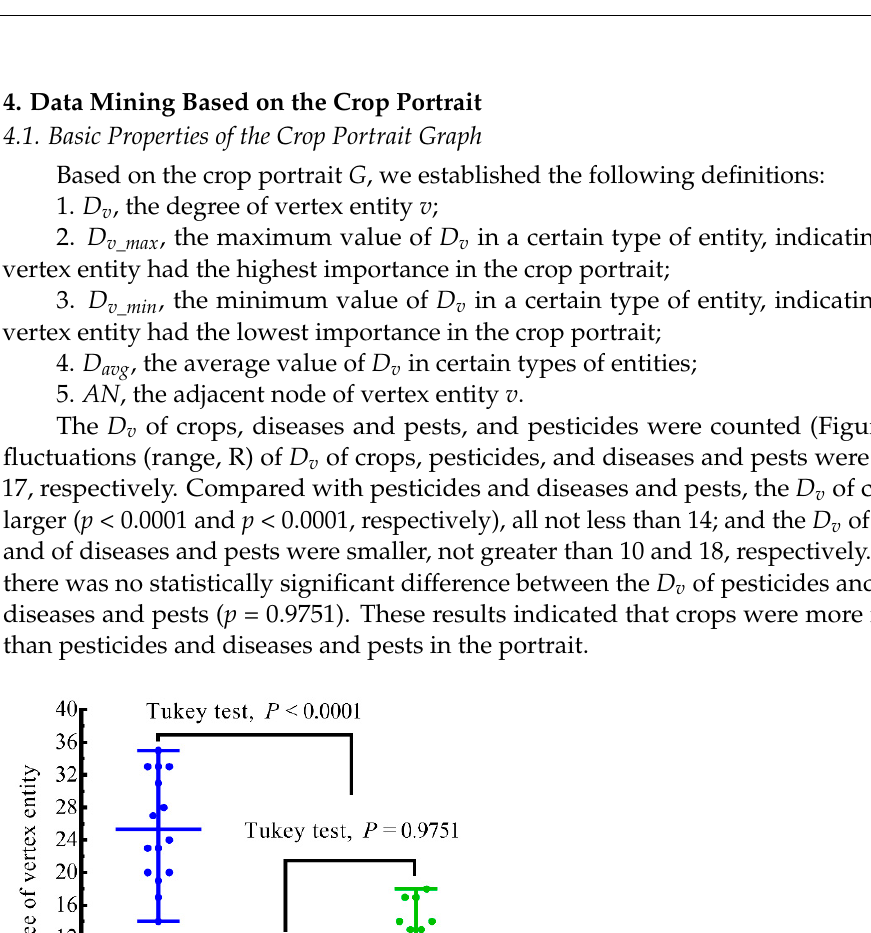
Figure 3. The relations of entities and their instances in the portrait. The light blue circles represent the three entities, the orange circles represent instances of crops, the light gray circles represent instances of pesticides, and the red circles rep- resent instances of diseases and pests.